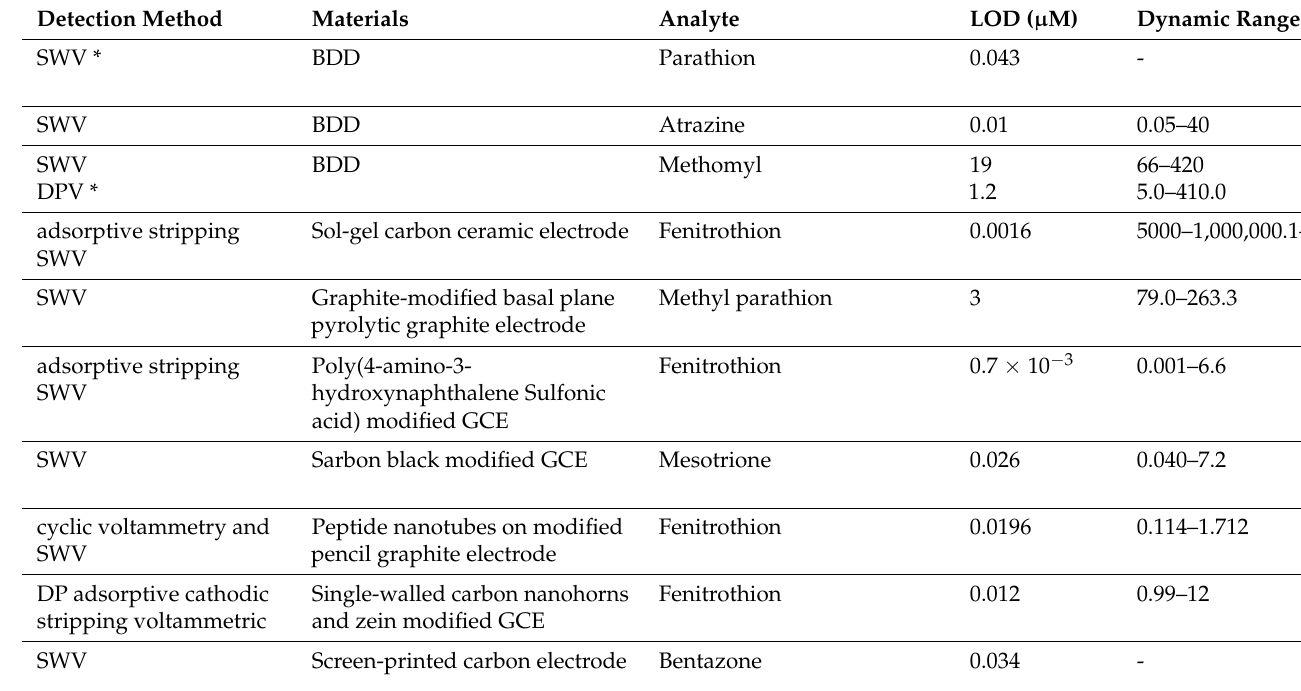
Table 2. Overview of electrochemical sensors for pesticides, based on (modified) carbon materials at the working electrode. Detection